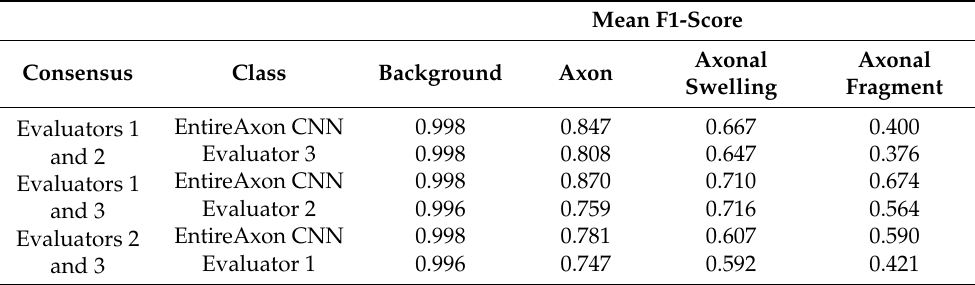
Table 3. Comparison of the mean F1 scores between the EntireAxon CNN and the human evaluator on the consensus labeling of the other two human